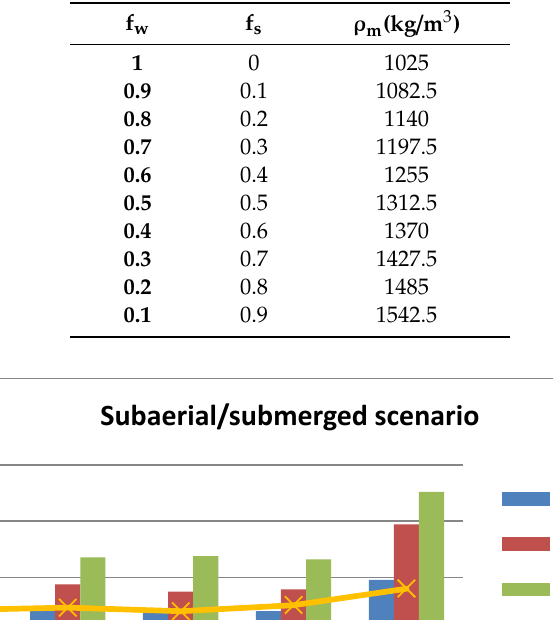
Table 4. The Terry and Malik [77] relationship between seawater fraction (f w ) and sand fraction (f s ) connected to the average density of the seawater and sediment mix ( ρ m ).